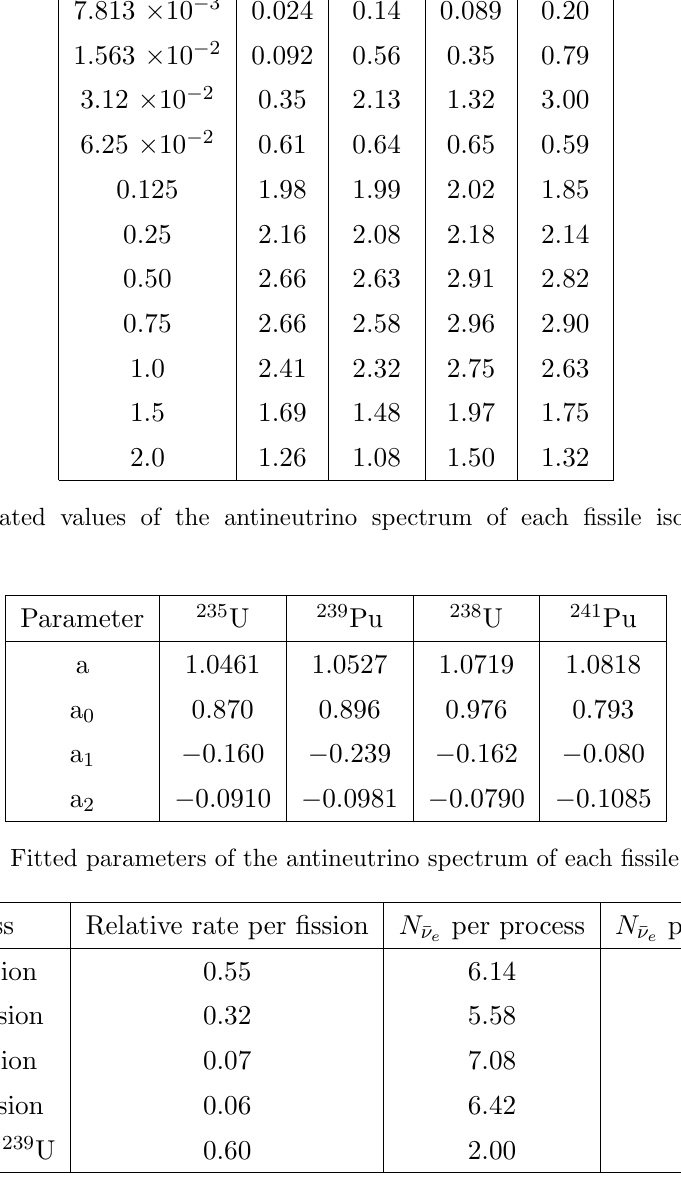
where d = 30 (cid:2) 10 2 cm is the distance between the reactor and the detector. The (cid:13)ux expected at the CONNIE detector is shown in (cid:12)gure